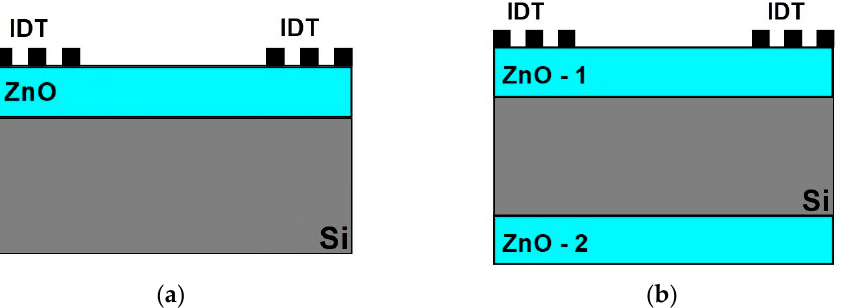
Figure 2. General view of acoustic delay line based on: ( a ) single thin ZnO film deposited on Si substrate; ( b ) double-layered structure of two ZnO films deposited on Si plate.